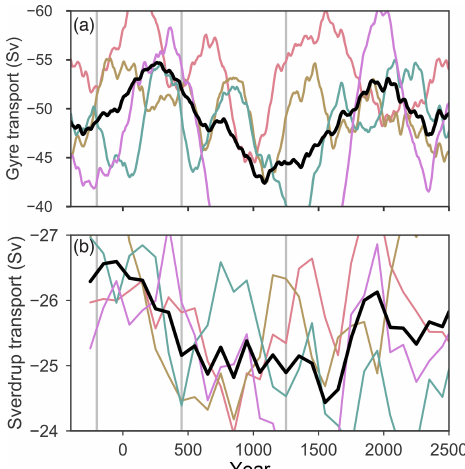
Figure 7. Strength of the North Atlantic subpolar gyre and the wind stress contribution (computed from the wind stress curl by integrat- ing the Sverdrup relation from east to west in each basin; Sverdrup, 1947). (a) 300-year running mean, (b) 300-year block means. Col- ors as in Fig. 1. Vertical lines mark the centers of the intervals se- lected for the analysis. As this figure is using 300-year averaging, they indicate the average values corresponding to the time windows used in the analysis. Note the different scales for gyre and Sverdrup transport.